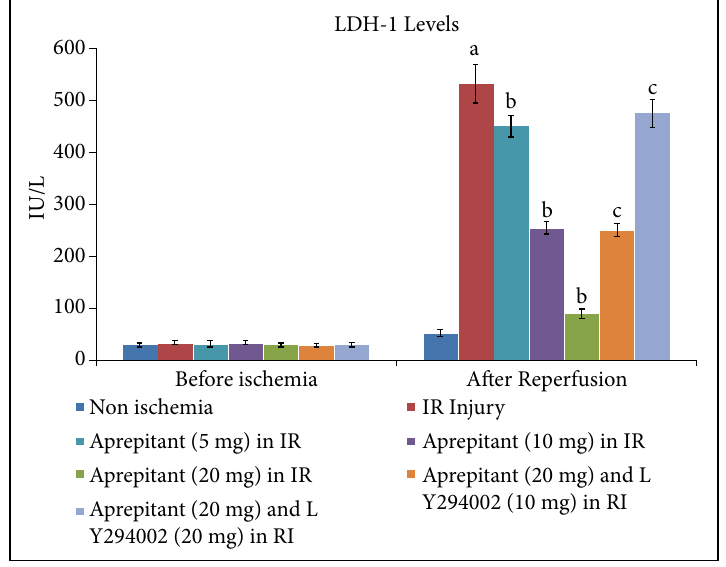
Figure 1 - Effect of aprepitant and LY294002 on ischemia-reperfusion- induced LDH-1 release in the coronary effluent. Values are given as mean ± SD. (a) p < 0.05 vs . non-ischemia; (b) p < 0.05 vs . IR injury; (c) p < 0.05 vs . aprepitant (20